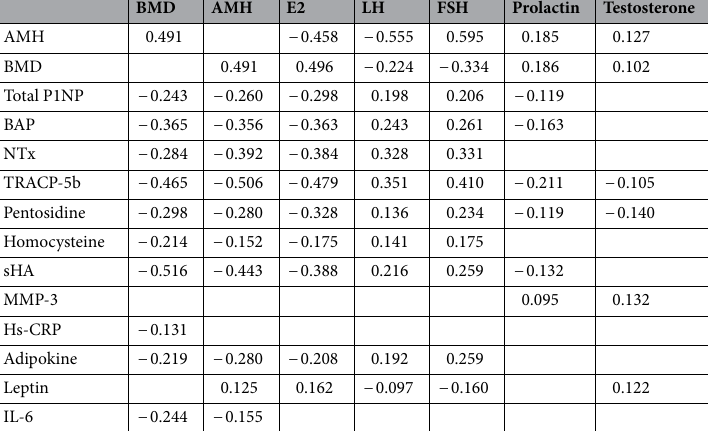
Standard partial regression coefficient p value Odds ratio 95% confidence interval Model 1: Risk for early knee OA in pre-menopausal females (Categorized AMH)